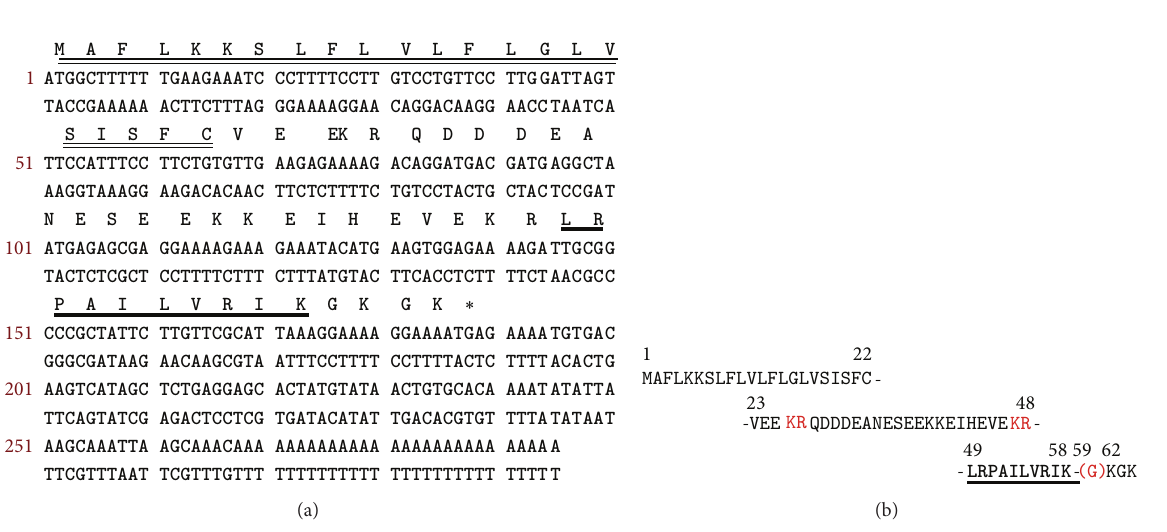
Figure 2: (a) Nucleotide and translated open-reading frame amino acid sequence of the sense strand of the cloned cDNA encoding the biosyntheticprecursorofbalteatide.Theputativesignalpeptideisdouble-underlinedandthematurebalteatidesequenceissingle-underlined. The stop codon is indicated with an asterisk. (b) Domain architecture of the balteatide precursor. Residues 1–22 constitute the putative signal peptide.Residues23–48constitutetheacidicspacerpeptideregiontypifiedbyclassical-KR-(-Lys-Arg-)propeptideconvertaseprocessingsites (italicised and in bold typeface). The single copy of mature balteatide (residues 49–58) is underlined and in bold typeface and the C-terminal glycyl (G59) residue that donates the amide moiety is indicated in